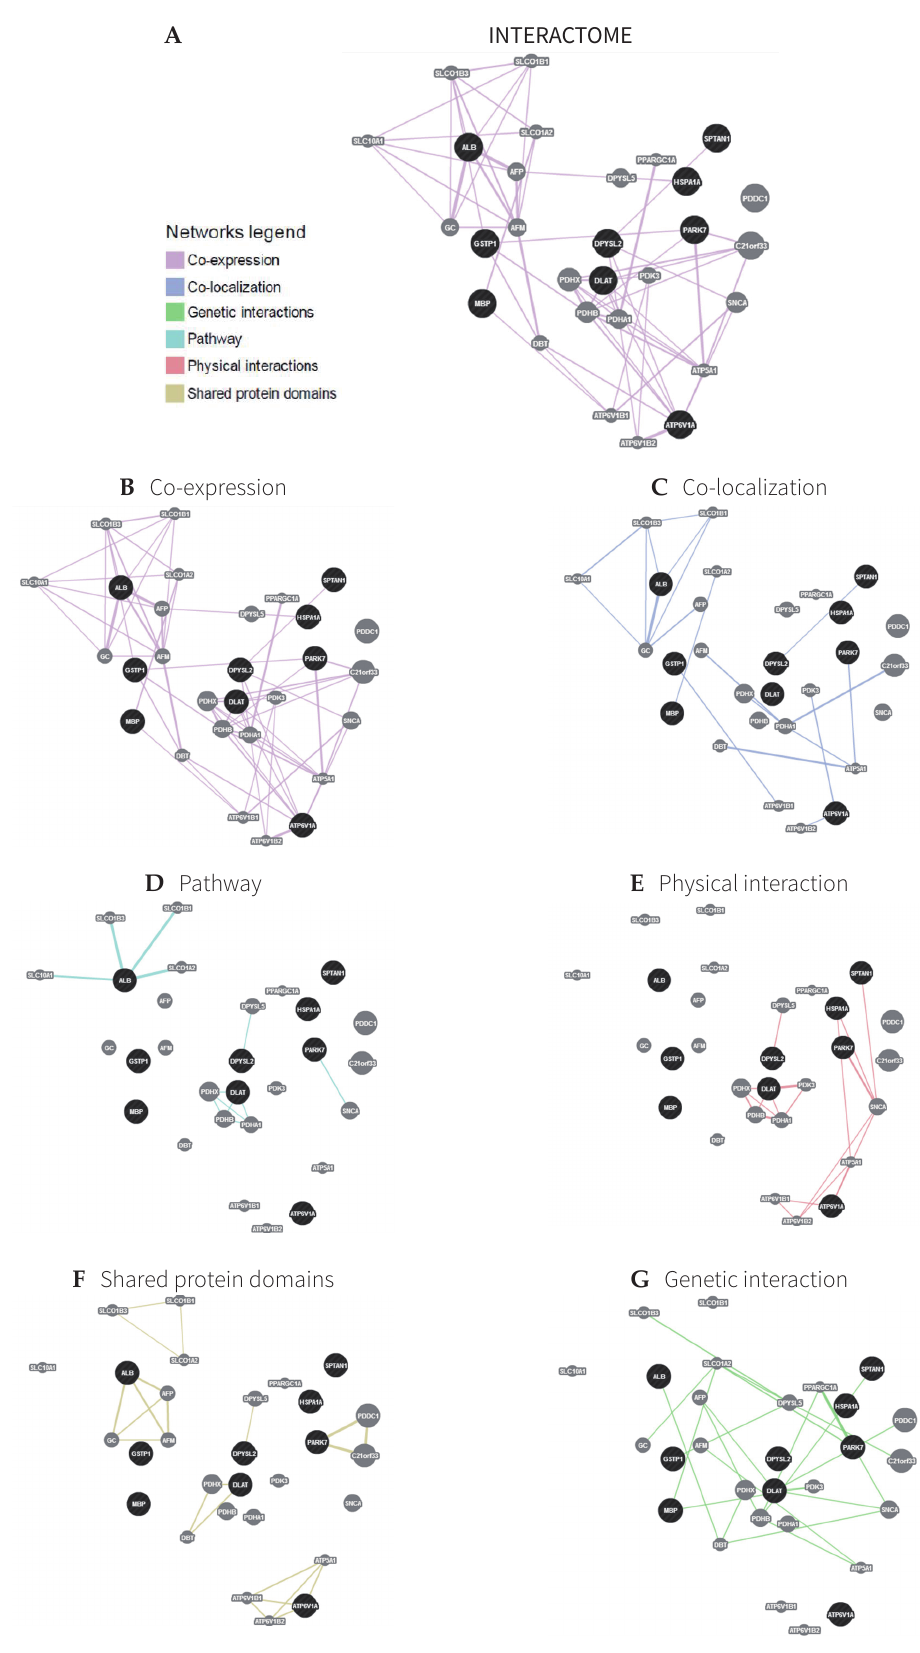
Figure 2. Schematic representation of the interactome showing the network between our proteins of interest with 20 other proteins. Proteins of interest are indicated in black and interacting proteins are indicated in gray. The size of the gray spots indicates the weight of the